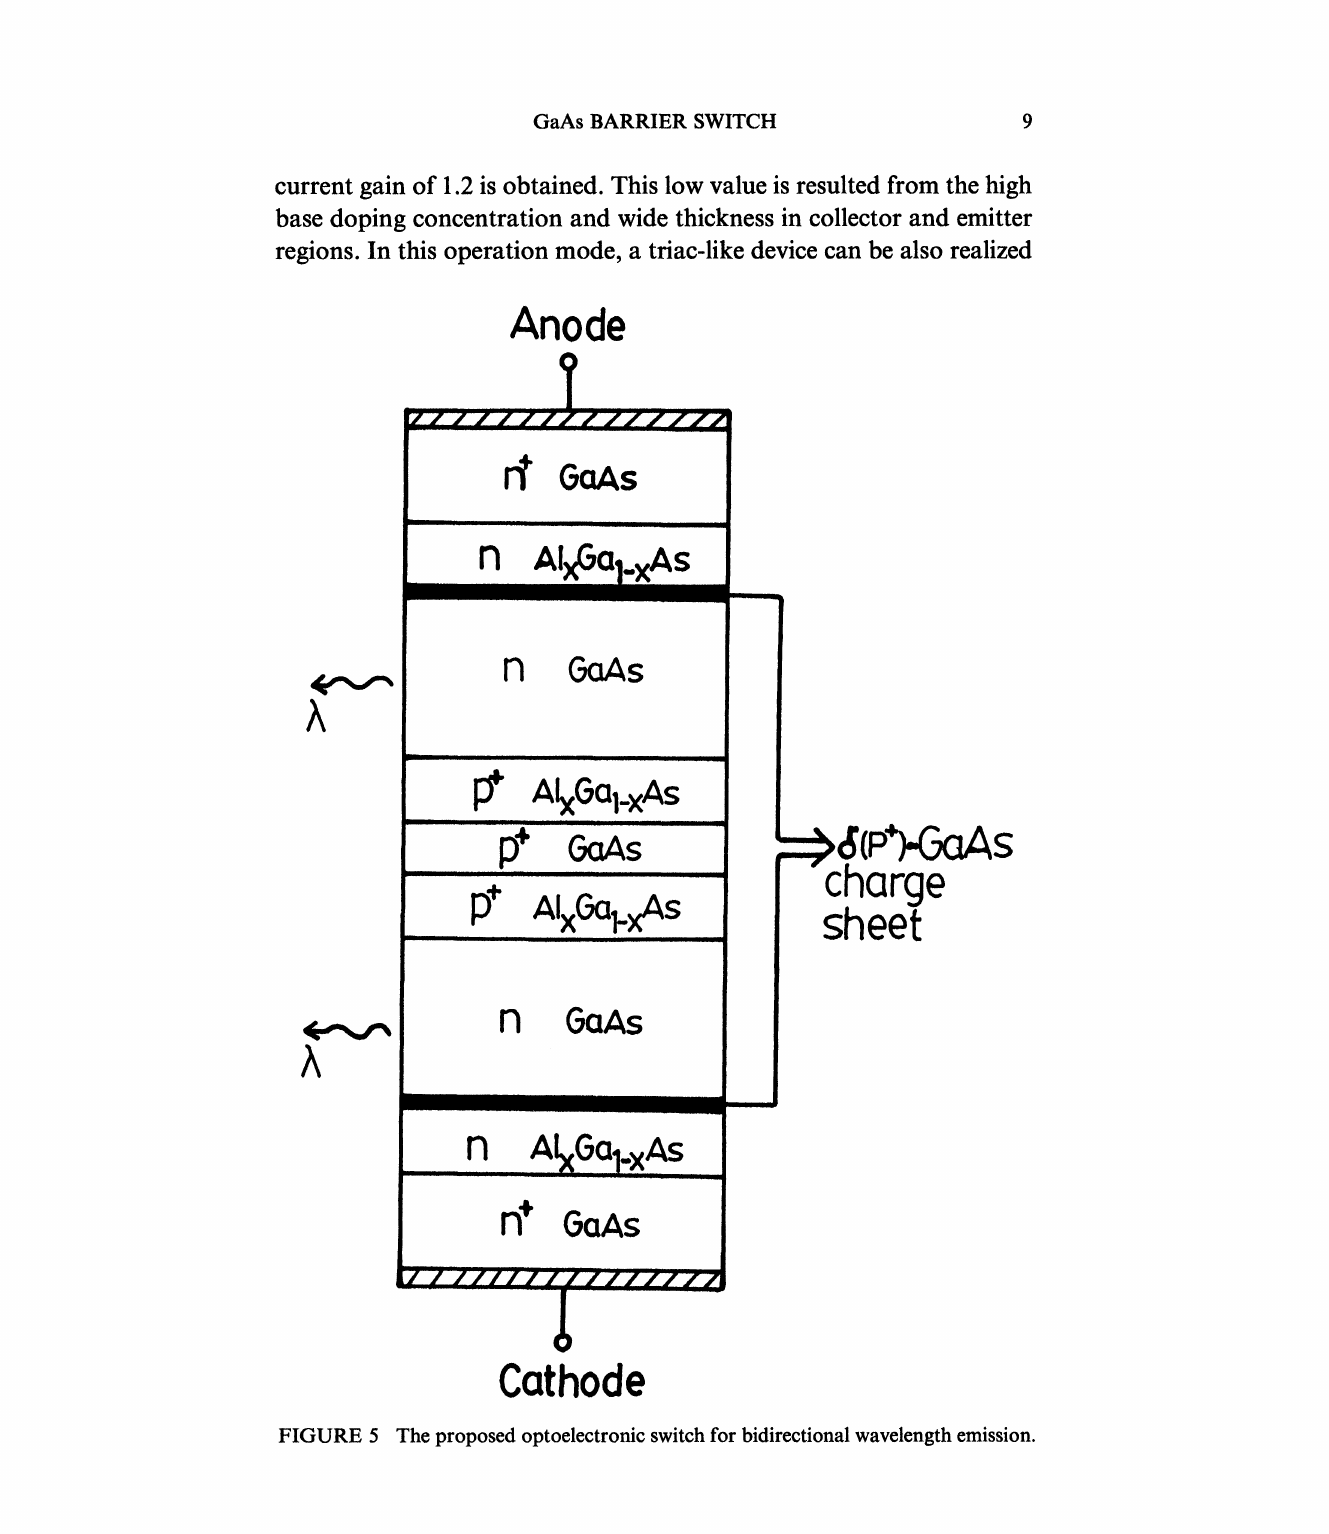
FIGURE 5 The proposed optoelectronic switch for bidirectional wavelength